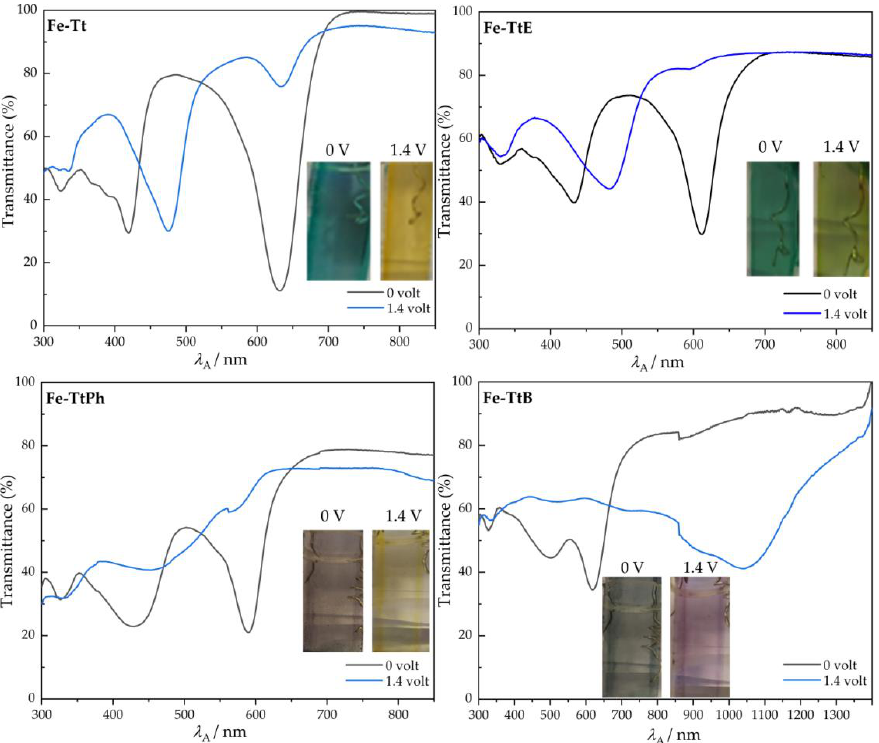
Figure 4. UV/vis to near-infrared (NIR) absorption spectra of Fe-MSP films in the colored (black curve, 0 V) and bleached (blue curve, 1.4 V) state. Insets: The photographs of Fe-MSPs in colored and bleached states.